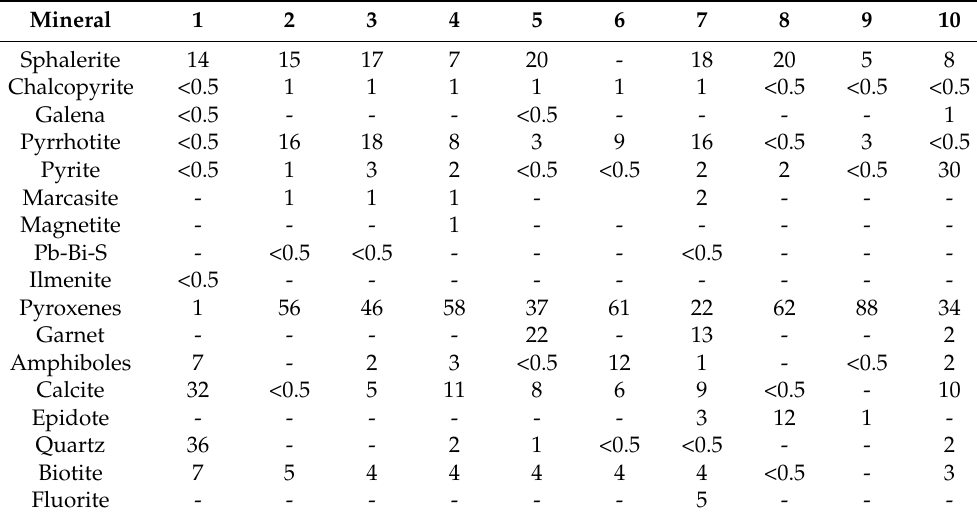
Table 2. Area proportion (%) of each mineral identified by modal analysis of microscope images of the feed sample.